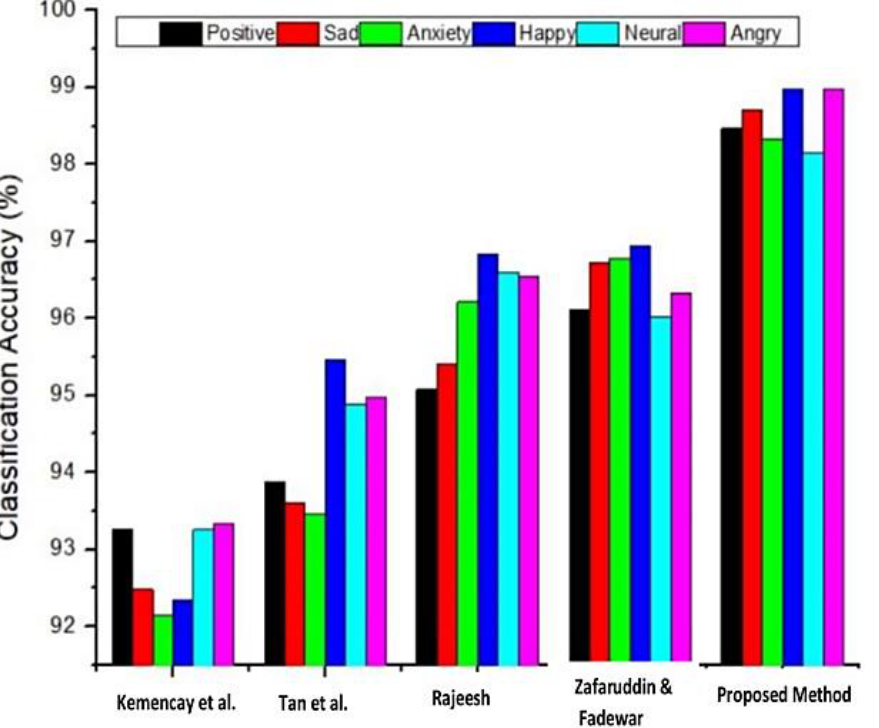
Figure 16. Classification accuracy analysis for different emotions base on the Extended Yale-B dataset [7,30 – 32].